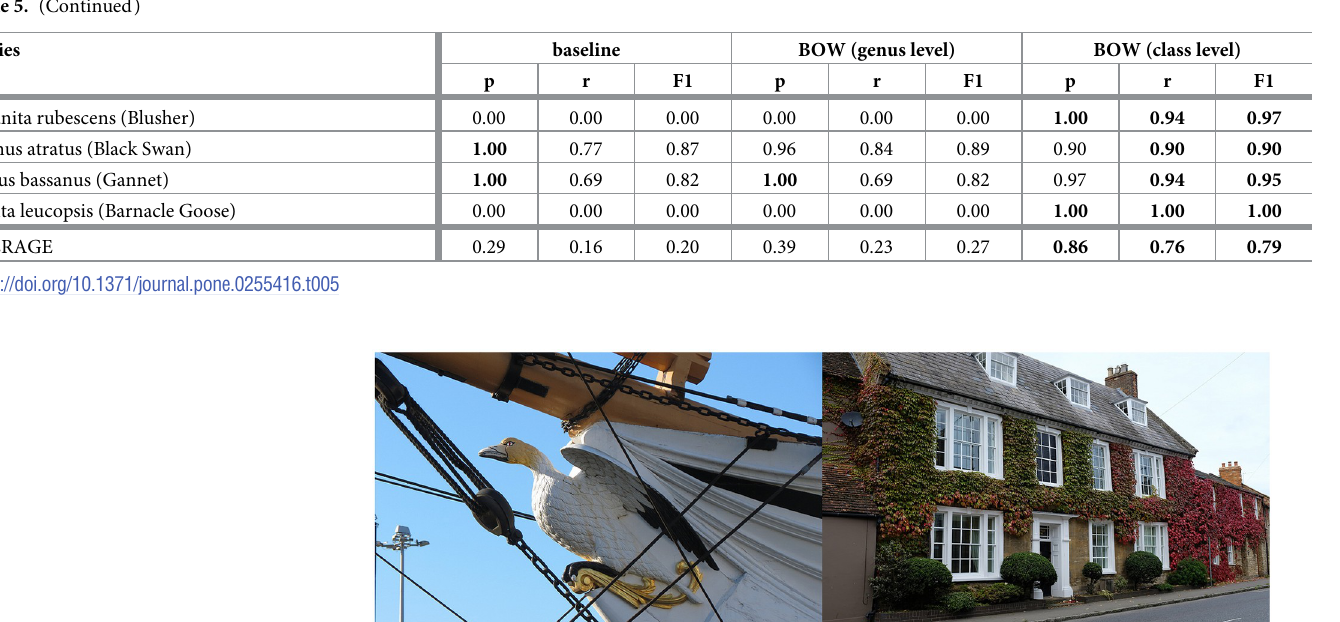
Flickr records. Further, according to the conditions for three by three analysis comparisons, false negatives occur when a set of nine cells have at least one NBN record in the absence of any Flickr record for the given species. Therefore, for species where the number of NBN rec- ords is high and the number of Flickr records is low it is very likely that cells with no Flickr occurrences will be associated with cells containing NBN records (note however that for spe- cies that are well represented on Flickr this is less likely to be the case). The highest precision and recall scores across both types of analysis are achieved for experi- ments performed with cell size 40km and no temporal constraints. The lowest results are achieved for experiments performed with a time constraint of twelve months which we attri- bute to lack of data on Flickr.